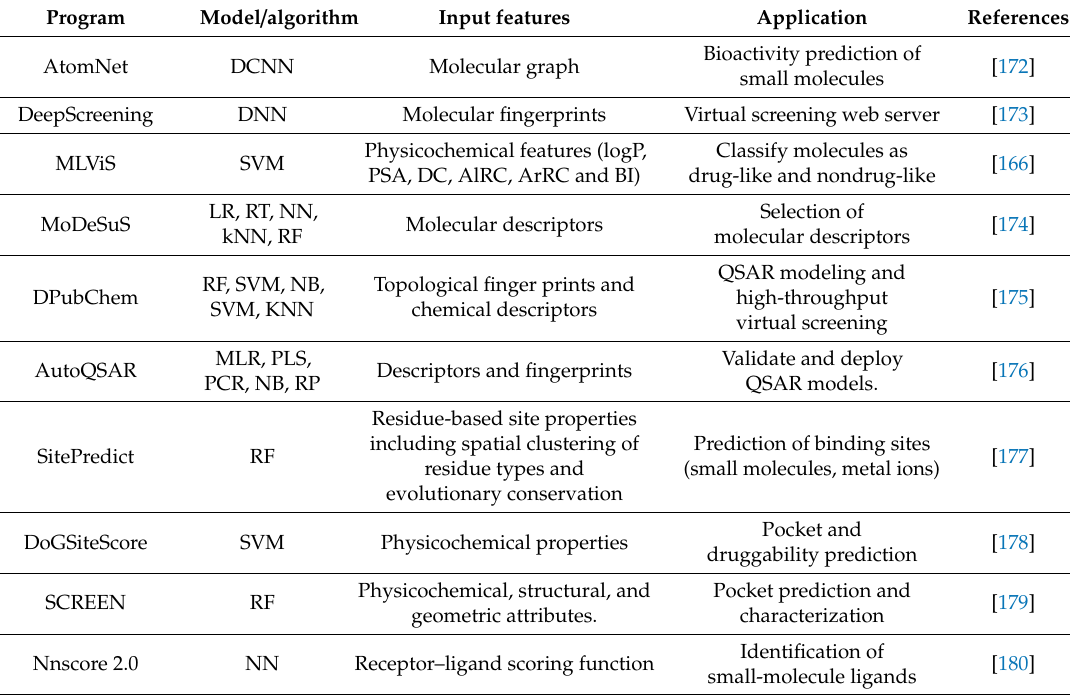
Table 2. Algorithms / programs using machine learning (ML)